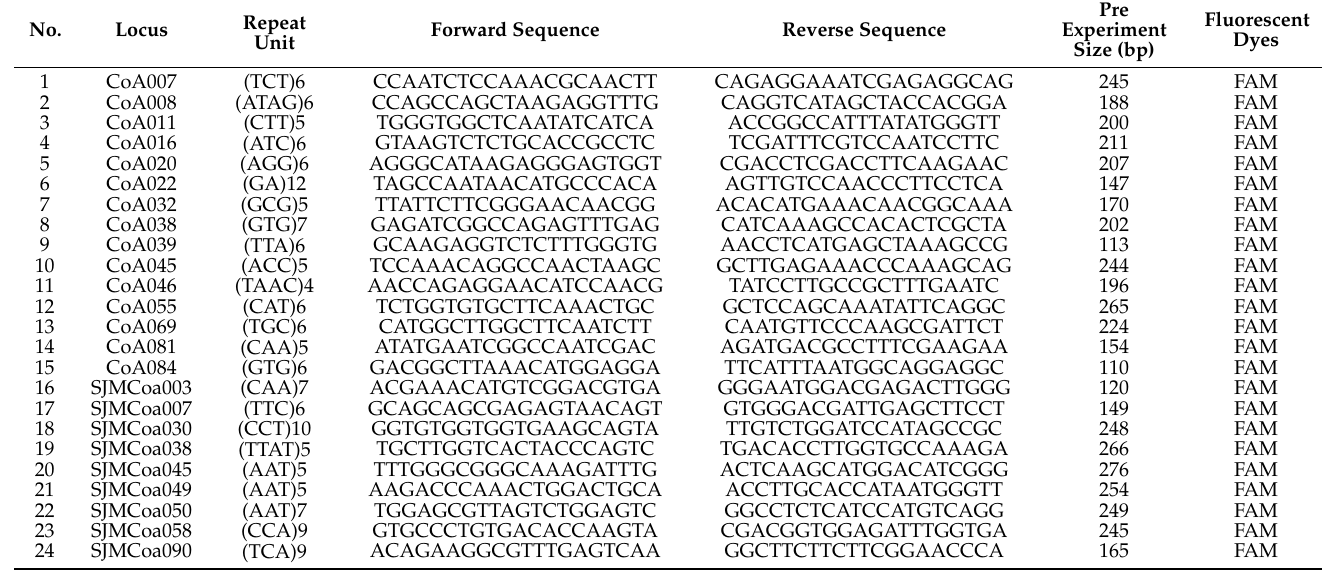
Table 2. Detailed information for 24 pairs of primers in the